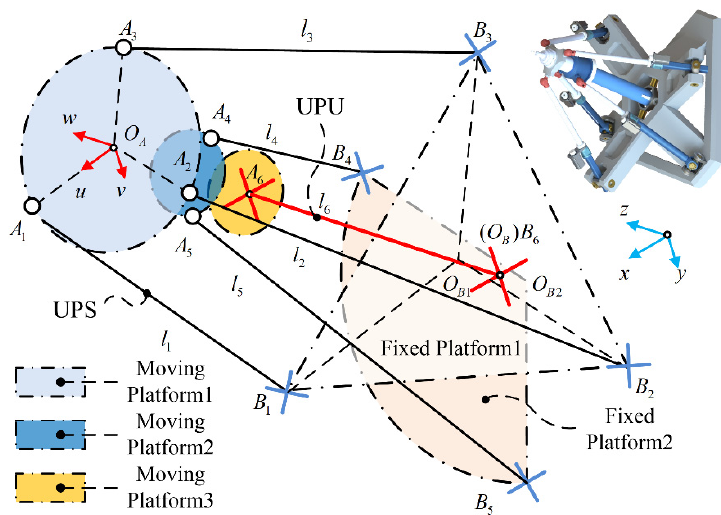
Figure 2. A − type mechanism diagram.